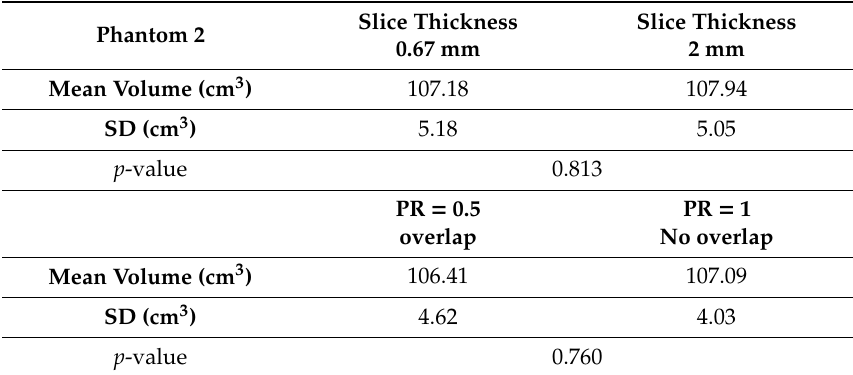
Table 3. Results from preliminary assessment of EVAR-eaSE accuracy using radiological phantom